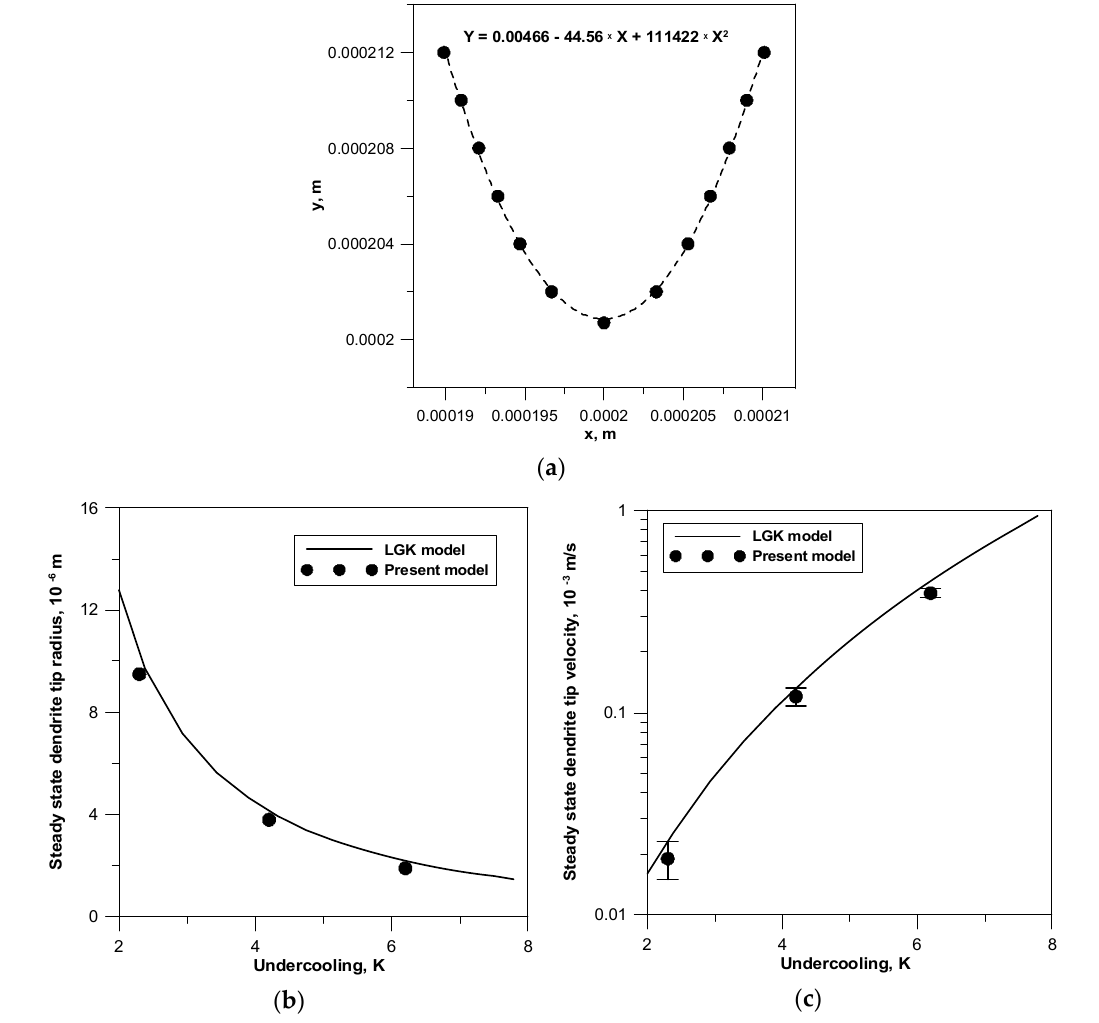
Figure 6. Comparison of the predictive parameters of the LGK model and the developed CA model: ( a ) the shape of the dendrite front and its parabolic approximation, ( b ) the effect of concentration undercooling on the dendrite front diameter, ( c ) the effect of concentration undercooling on the velocity of the dendrite front.